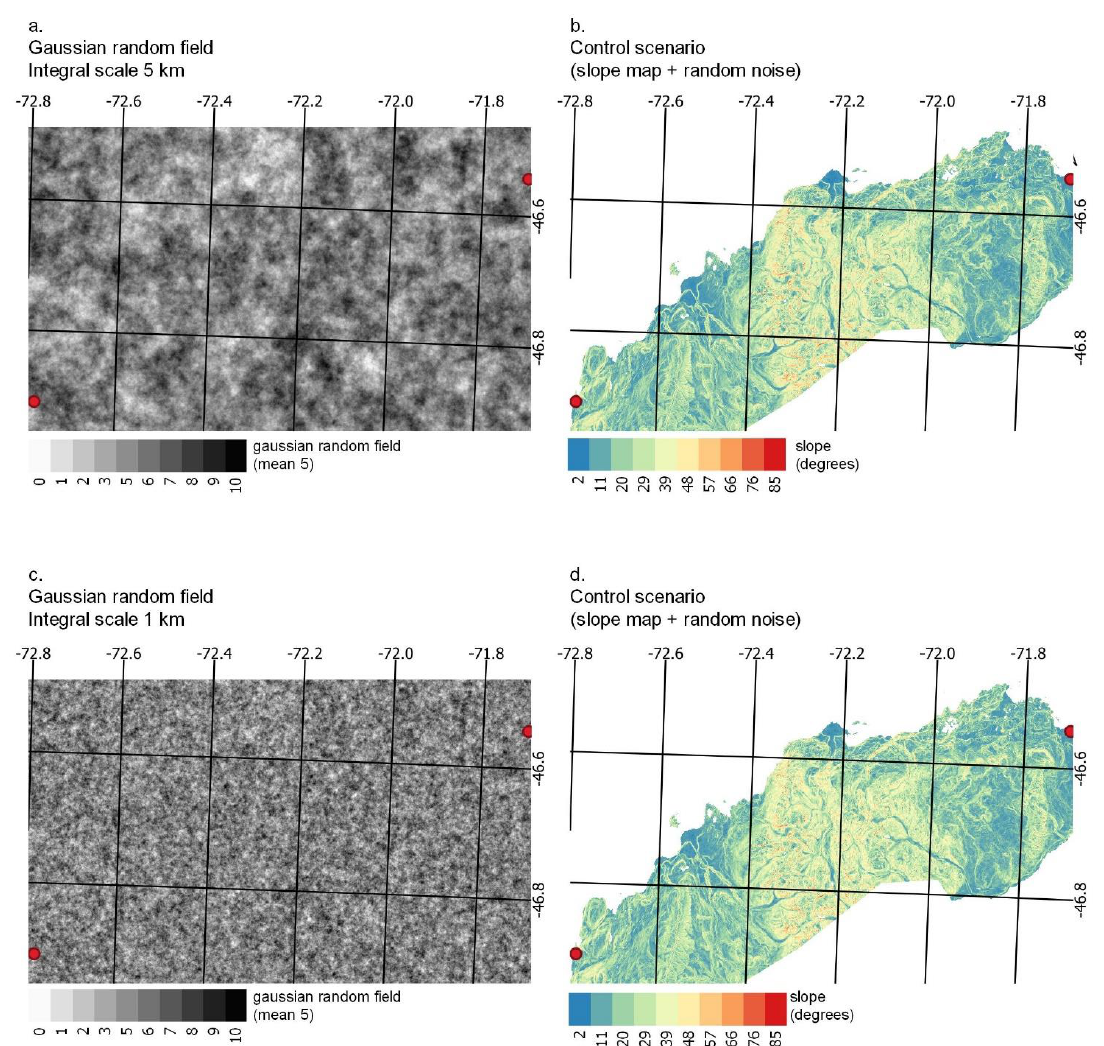
Figure A1. Sensitivity test for different Gaussian random fields. ( a ) Gaussian random field using an integral scale of 5 km, variance of 2, and mean of 5; ( b ) Cost surface corresponding to the addition of slope and the Gaussian random field from a; ( c ) Gaussian random field using integral scale of 1 km, variance of 2 and mean 5; ( d ) Cost surface corresponding to the addition of slope and the Gaussian random field from c .